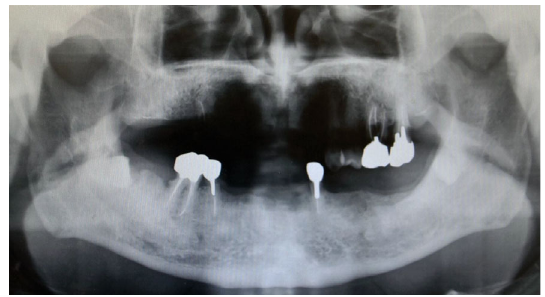
Figure 1: Photoradiograph showing the patient ’ s teeth before the fi rst